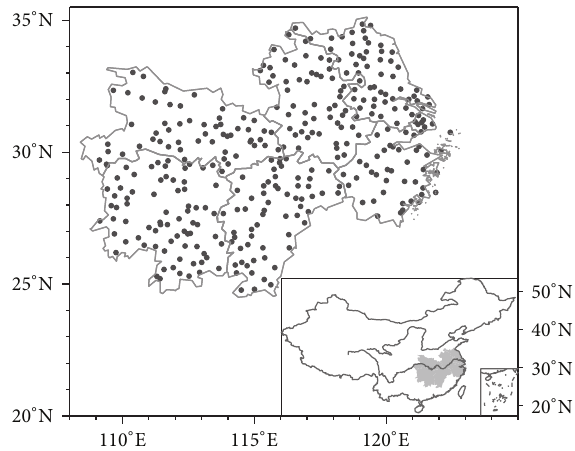
Figure 1: The spatial distribution of 353 stations over the middle- lower reaches of the Yangtze River basin (MLRYRB); the shading area is the location of the